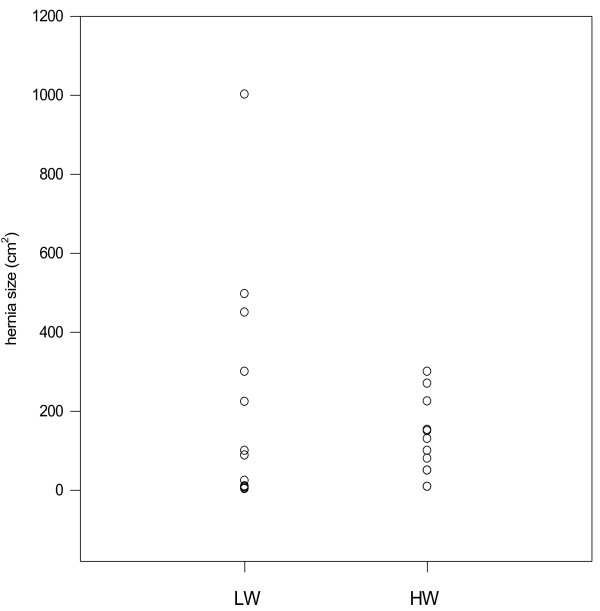
Hernia size of the HW and LW-group.